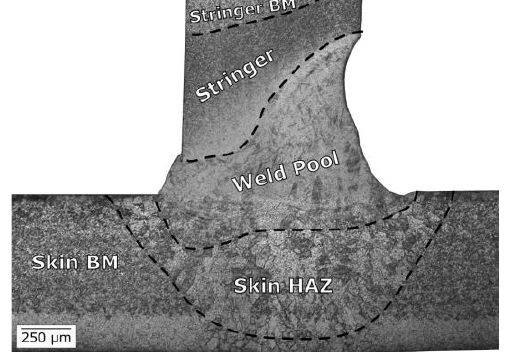
Figure 4. Micrograph showing molten weld pool and HAZ.